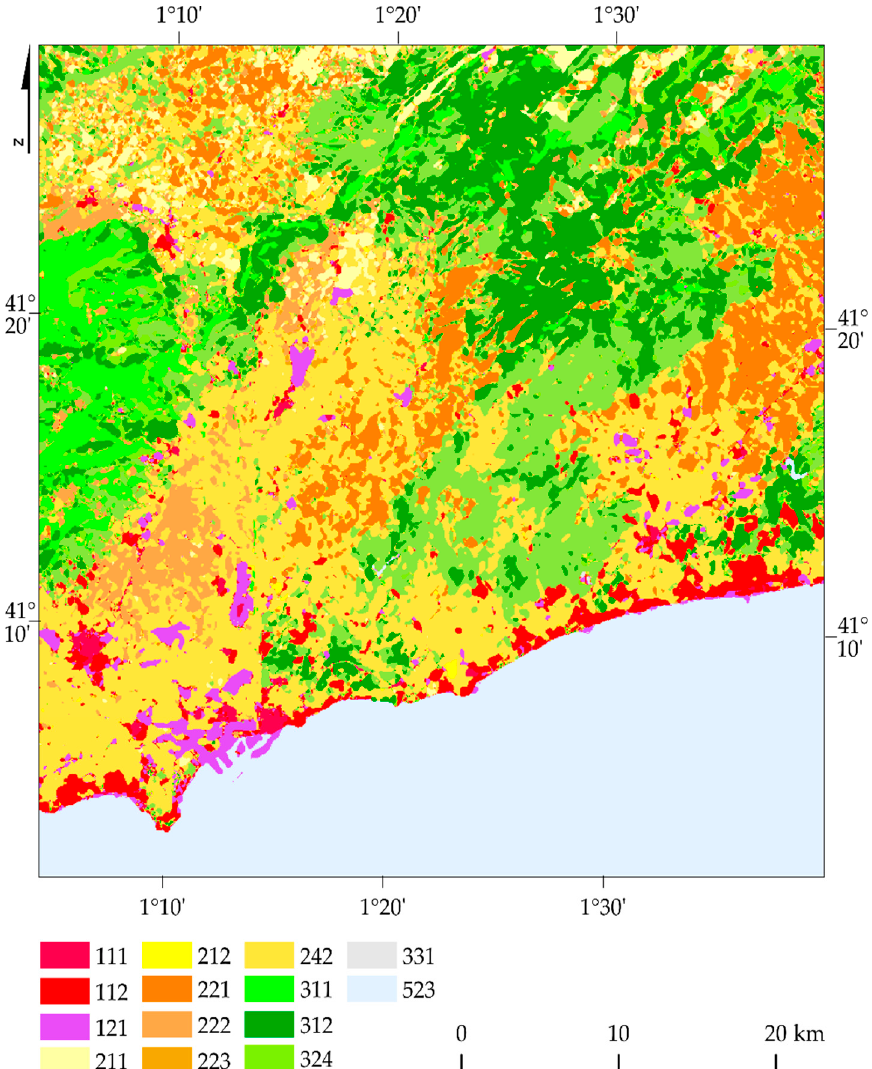
Figure 16. Catalonia map based on Support Vector Machine, Radial Basis Function kernel classifier, Sentinel-2 images, Overall accuracy: 76%, Kappa coefficient 0.74.